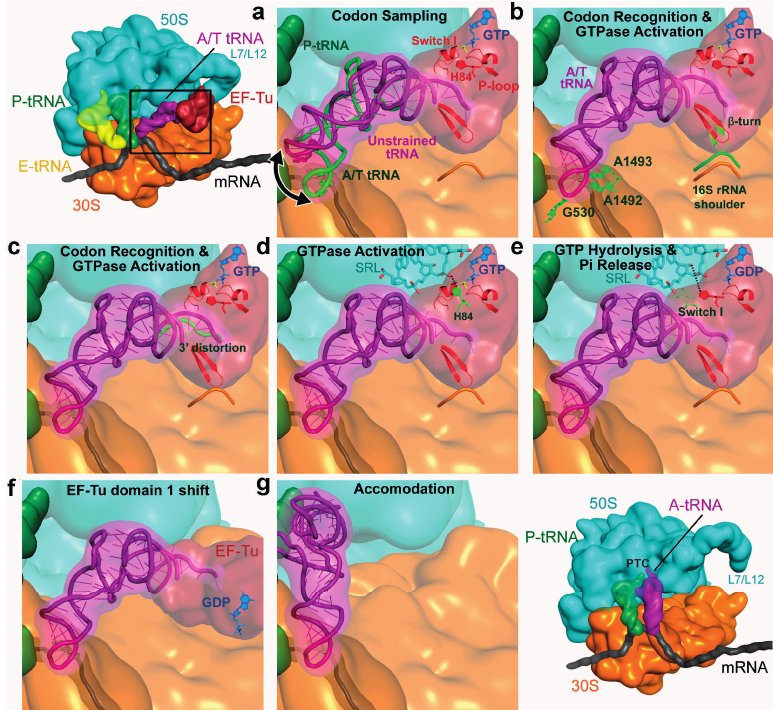
Figure 5. Graphic representation of the sequential stages during tRNA